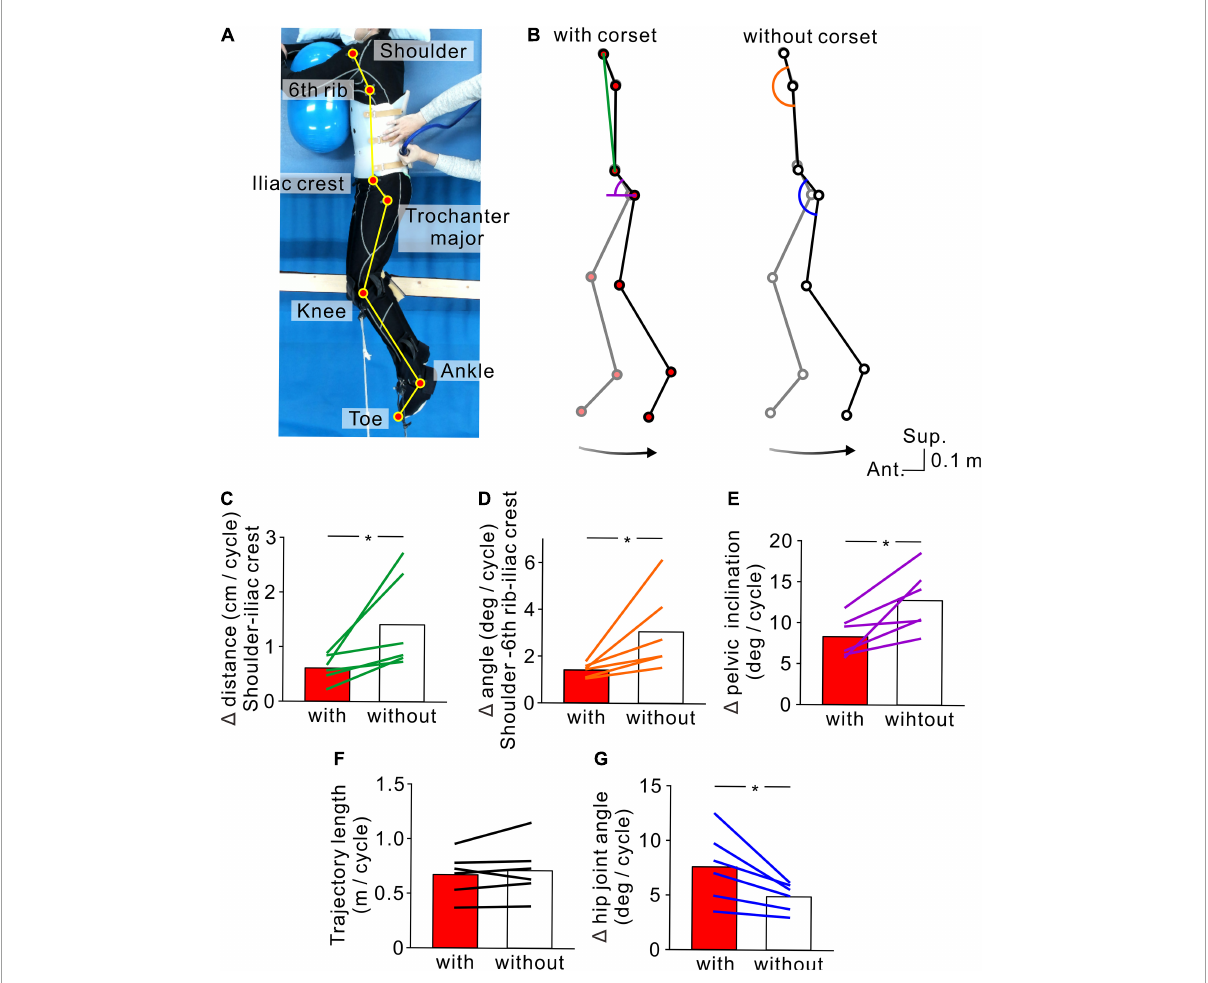
FIGURE4 Kinematics of stimulus-evoked hopping-like leg movements. (A) Participant posture and reflective markers for three-dimensional motion capture. (B) Stick pictures showing examples of left leg movements evoked by transvertebral magnetic stimulation in the conditions with (left) and without (right) the lumbar corset. Note that the stick pictures represent the foremost (gray line) and rearmost (black line) positions of the left toe in a cycle. Colored line and semicircles indicate the measures for lumbar spine movements (green line = distance between the left shoulder and iliac crest, orange semicircle = angle formed by the left shoulder and 6th rib under the arm and iliac crest, purple semicircle = pelvic inclination angle against the antero-posterior axis, and blue semicircle = hip angle). Bottom arrows show the toe trajectory of the above stick pictures. Population data ( n = 6) of the distance between the left shoulder and iliac crest (C) , angle formed by the left shoulder and 6th rib under the arm and iliac crest (D) , pelvic inclination against the antero-posterior axis (E) , toe trajectory length (F) , and hip joint angle (G) . Red and white boxes represent the values in the conditions with and without the corset, respectively. Lines over the boxes represent individual participants. Significant differences were revealed by paired t -tests (* p <